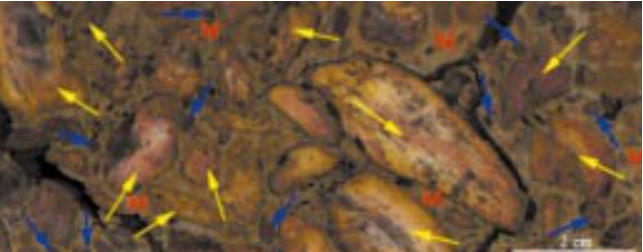
Figura 4. Imagem do bloco impregnado correspondente ao horizonte Bt4 do perfil 2. Verifica-se a grande quantidade de cascalhos e calhaus de quartzo (setas amarelas), arestados ou não, imersos na matriz do solo (M) onde, também, são vistos inúmeros nódulos concrecionários de ferro (setas